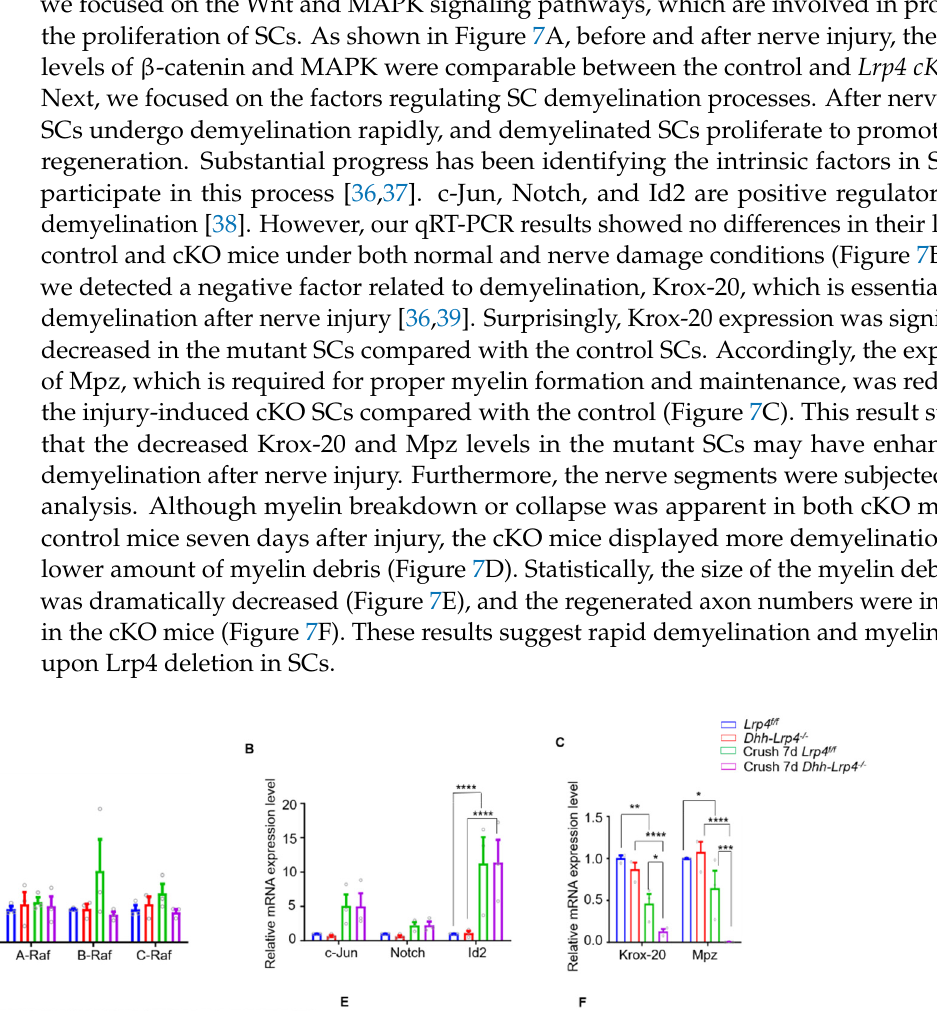
proximal and distal ends of the crushed nerve segments did not differ between the control and cKO mice. The white arrows indicate the macrophages. Scale bar = 25 μ m ( D ) Quantification of the macrophage numbers revealed no significant difference between the control and cKO mice. Control and cKO, n = 10 slices, 3 mice/group.